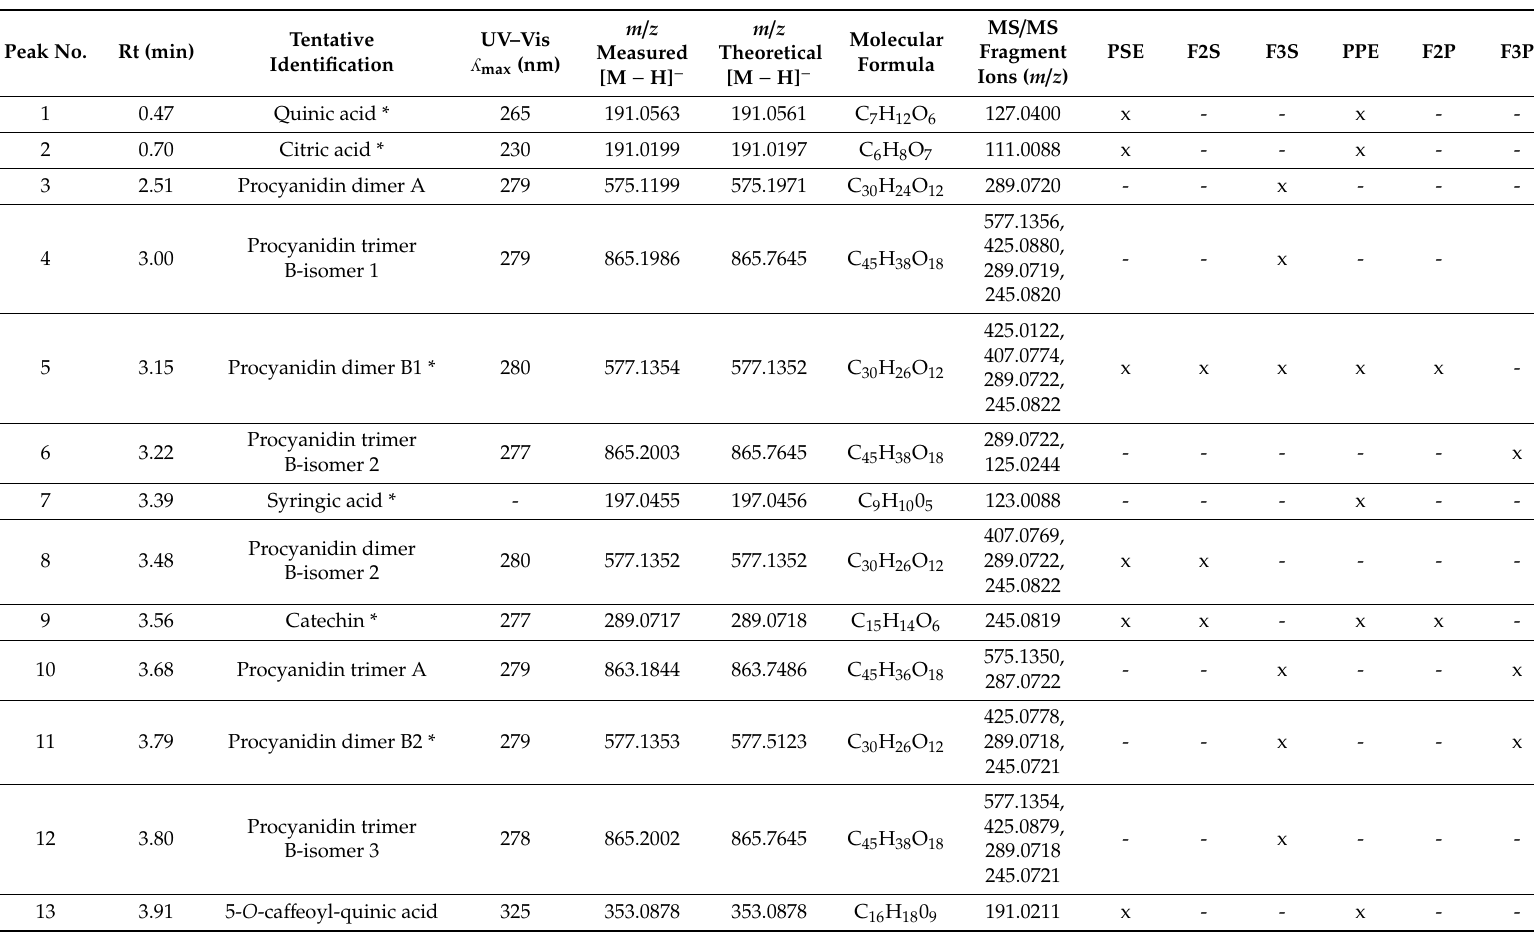
Table 2. Characterization of Phenolic Compounds in Fractions of Persea americana Mill. Nariño cultivar Byproducts (seeds and peels). For peak assignation see Figure 2. Peak